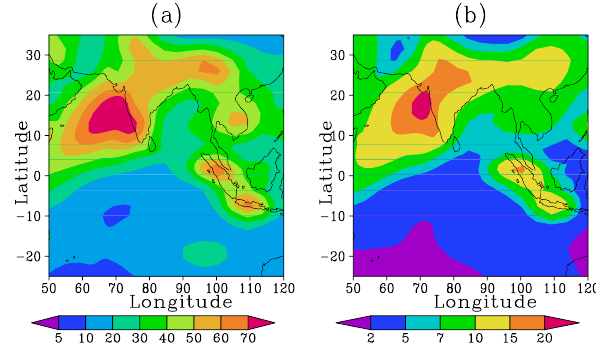
Fig. 12. Spatial distribution of particle number concentration (di- vided by 100) for January to March at surface in (a) Aitken mode and (b) accumulation mode concentration (particle cm − 3 )